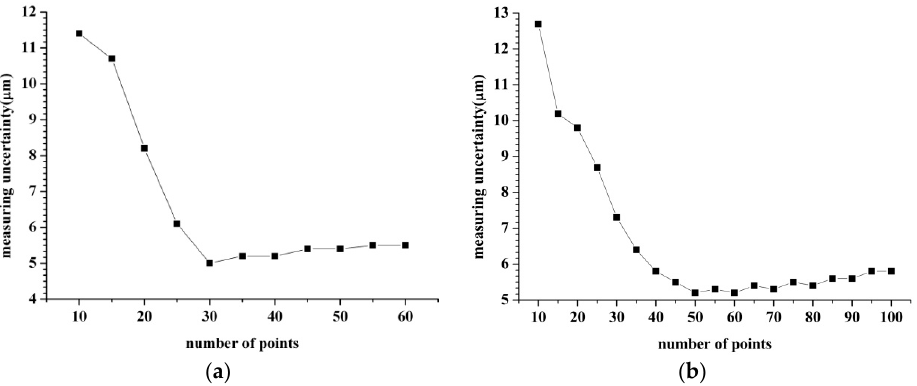
Figure 7. The number selection of calibration points. ( a ) The diameter of the measured hole is 150 mm; ( b ) The diameter of the measured hole is 275 mm.